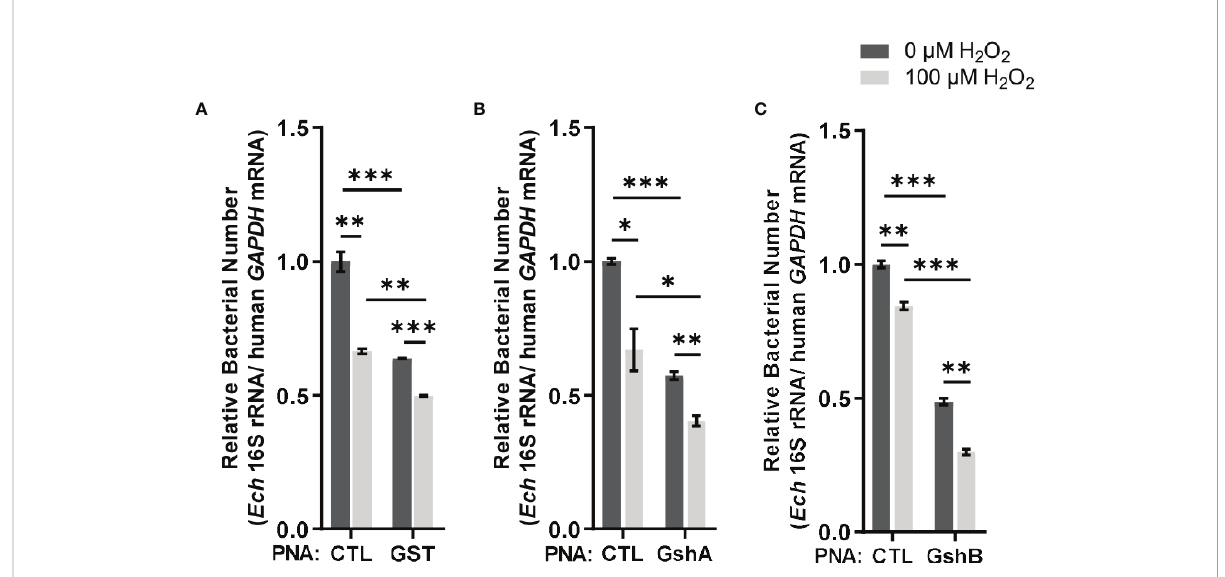
FIGURE 5 Transfection of GST PNA (A) , GshA PNA (B) or GshB PNA (C) reduces the survival ability of E. chaffeensis upon oxidative stress. At 36 h p.i. THP- 1 cells synchronously infected with GST PNA-, GshA PNA-, GshB PNA- or CTL PNA-transfected E. chaffeensis were treated with H 2 O 2 at a fi nal concentration of 100 m M or culture medium (CTL) at 37 °C for 2 h. Relative bacterial numbers was determined as the amount of bacterial 16S rRNA normalized against that of human GAPDH mRNA. Relative values to the amount of CTL PNA-transfected E. chaffeensis without H 2 O 2 treatment are shown. Data indicate means ± standard deviations ( n = 3). The signi fi cant differences are represented by P -values determined with Student ’ s t test (* indicates P < 0.05, ** indicates P < 0.01, and *** indicates P <